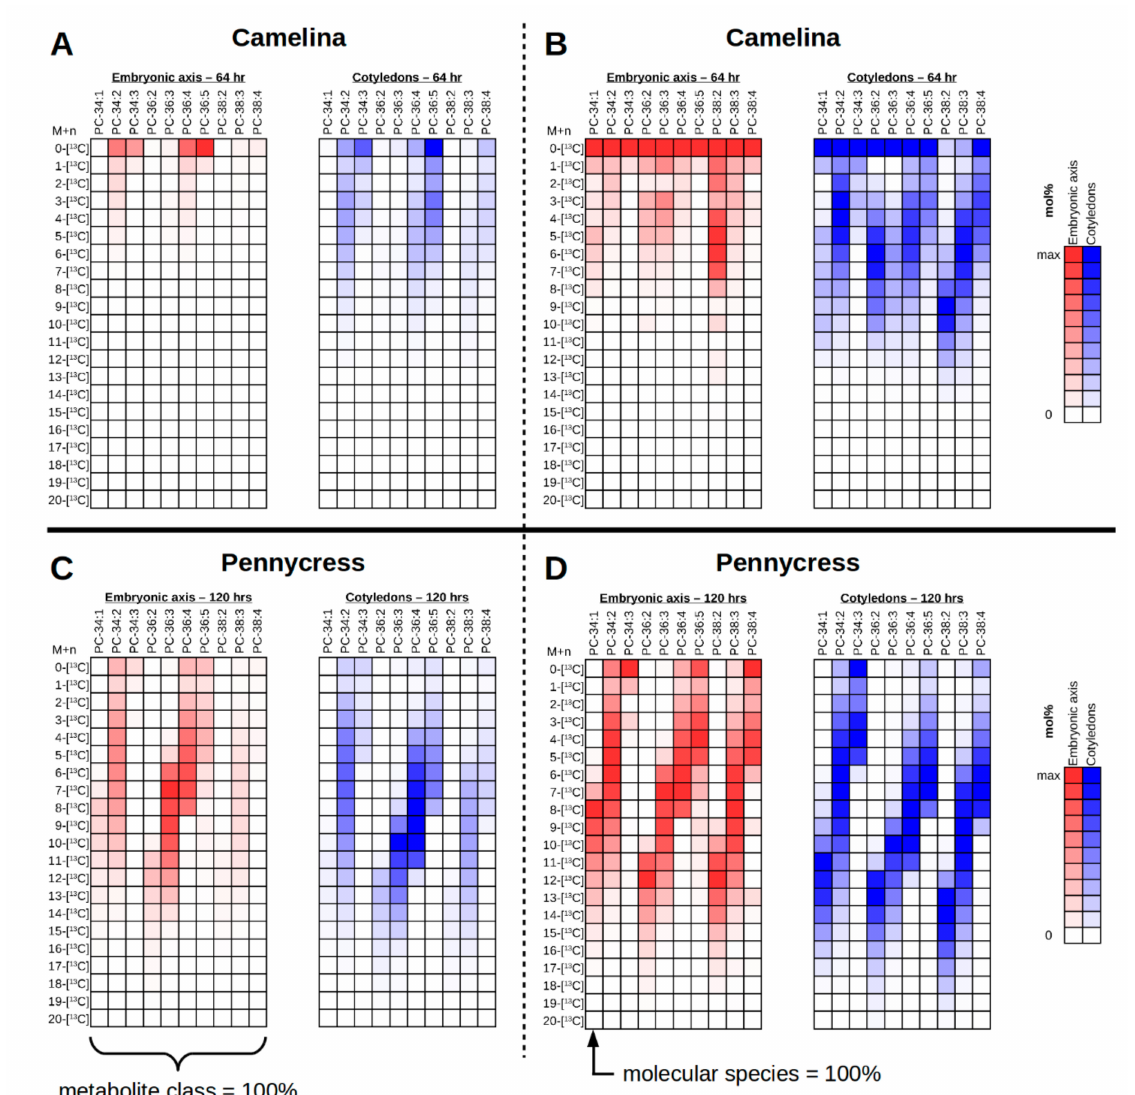
Figure 5. Isotopologue mol% abundance for PC of the different tissues of a 13 C-labeled Camelina embryo ( A , B ) and a 13 C-labeled pennycress embryo ( C , D ). Mol% abundance values are exported from MSiReader using “MSi Export” and ROI selection of either the embryonic axis (red) or the cotyledons (blue). Summed values are normalized either to the entire metabolite class ( A , C ) to depict relative abundance, or for each individual molecular species ( B , D ) to depict 13 C-labeling patterns. The natural 13 C abundance was corrected using IsoCorrectoR